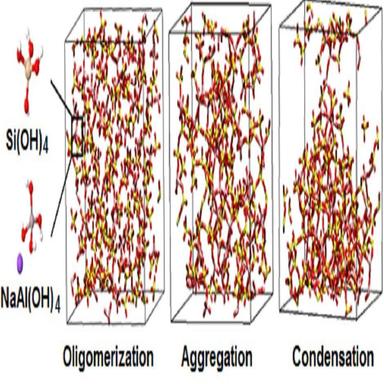
D simulation